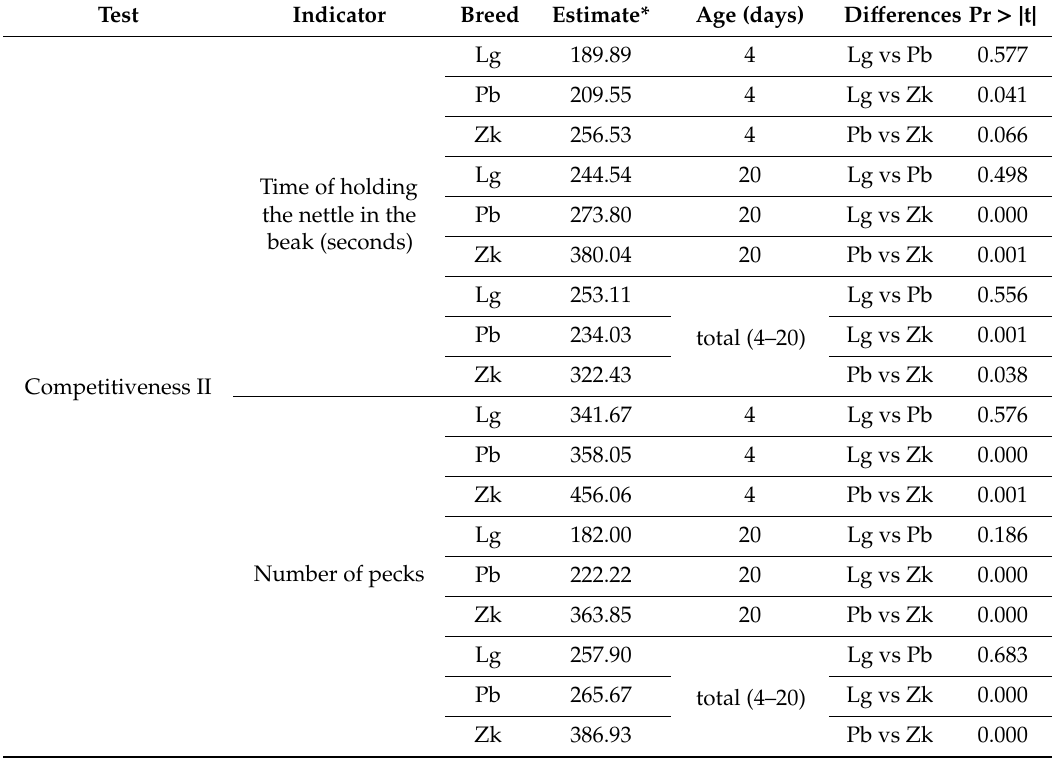
Table 3. Mean level of analysed indicators* and significance of di ff erences between the means in the Competitiveness II test in relation to the breed and age of